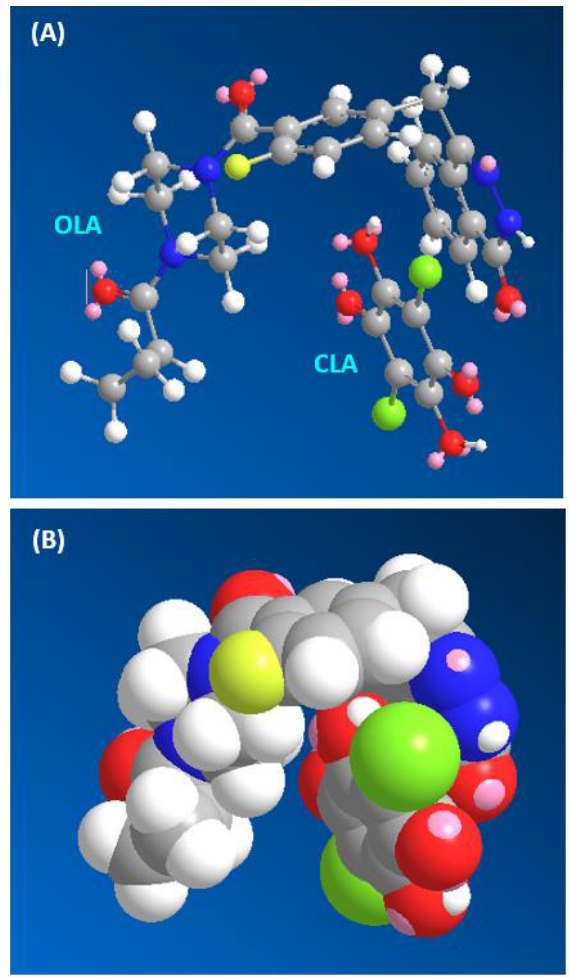
Figure 6. Energy-minimized CTC of CLA with OLA in the conformational ( A ) and 3D structures ( B